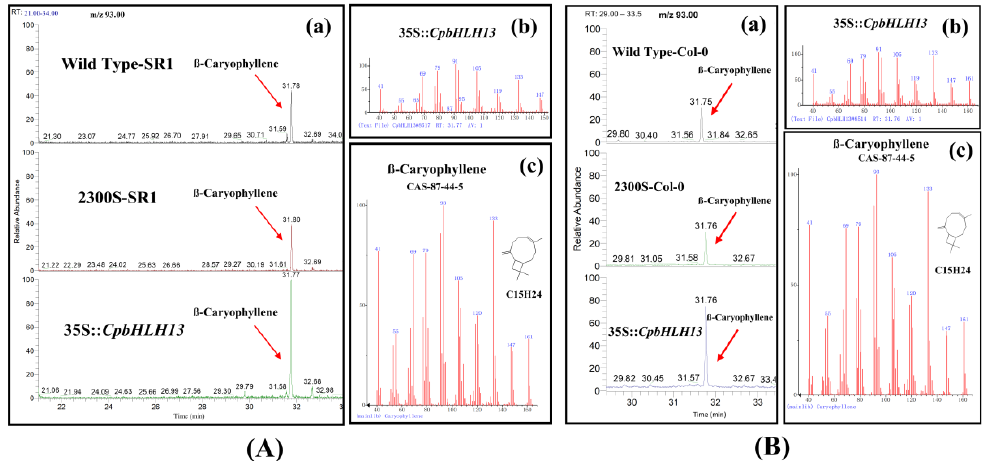
Figure 8. GC-MS analysis of β-caryophyllene emitted from the flowers of ( A ) tobacco wild type SR1, transformed by the empty vector pCAMBIA2300S (2300S-SR1) and overexpressed CpbHLH13 gene (35S: :CpbHLH13 ) plants; ( B ) arabidopsis wild type (WT-Col-0), transformed by the empty vector pCAMBIA2300S (2300S-SR1) and overexpressed CpbHLH13 gene (35S: CpbHLH13 ) plants. (a) GC-MS chromatogram comparison between different plants. (b) Mass spectrum of the product. (c) Product confirmation in the NIST database according to retention index and mass spectrum.